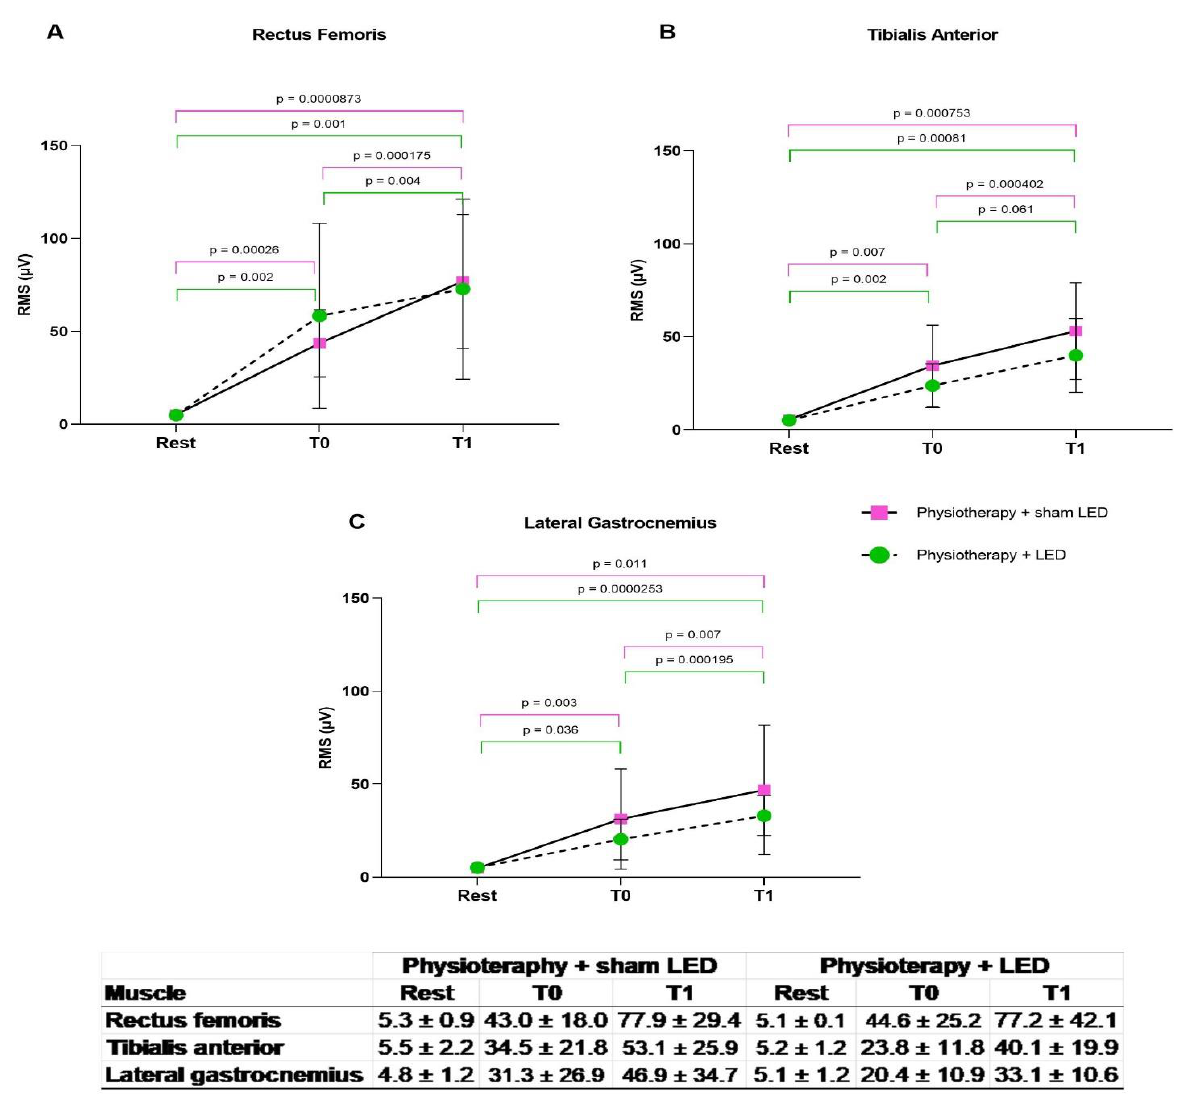
Figure 5. ( A – C ) RMS values of more compromised lower limb. Improvements in electrical muscle activity found in both treatment groups. T0 = pre-intervention; T1 = after 24 sessions; STS = sit-to- stand task.